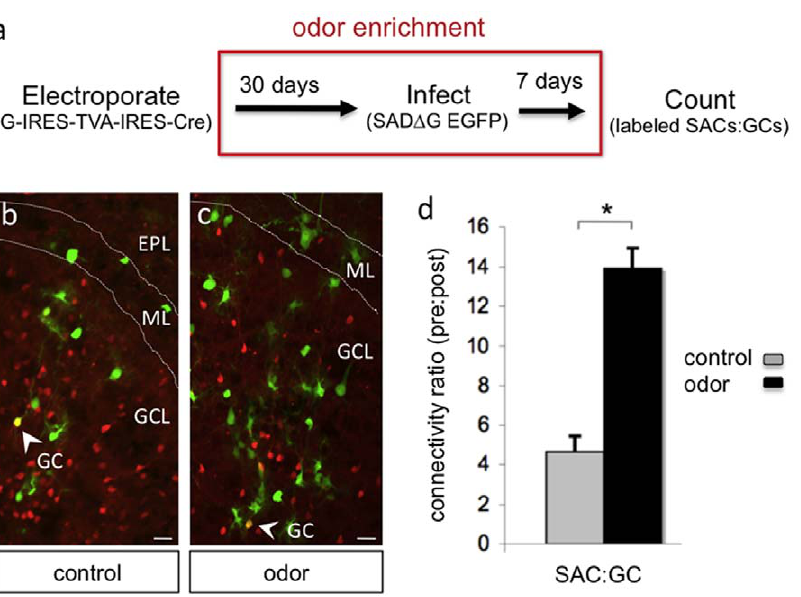
Figure 4. Odor Enrichment Increases SAC Connectivity onto Granule Cells. (a) Schematic of experimental paradigm to track changes in granule cell connectivity following odor enrichment. (b) Dual labeled region of a control olfactory bulb showing SAD D G-EGFP expression in presynaptic targets. Scale bar, 10 m m. (c) Dual labeled olfactory bulb from a mouse subjected to odor enrichment showing increased presynaptic labeling (green). Arrows points to source granule cells (GC) which appear yellow due to co-expression of tdTomato and EGFP. Presynaptic partners appear green. Scale bar, 10 m m. EPL, external plexiform layer; ML, mitral cell layer; GCL, granule cell layer. (d) Connectivity ratio between postsynaptic granule cells and presynaptic short axon cells (SAC:GC) under control conditions or following odor enrichment. * p , 0.01, Student’s t-test.